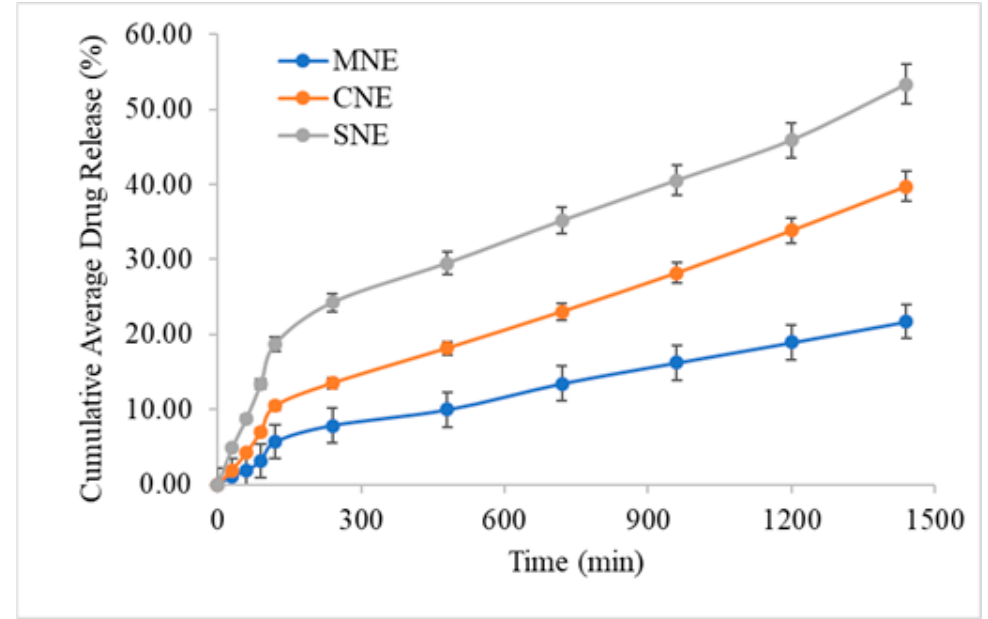
Figure 4. Release profiles of formulated nanoemulsions. Data were expressed as mean ± SD, n = 3, (ANOVA; p < 0.05). (ANOVA; p <